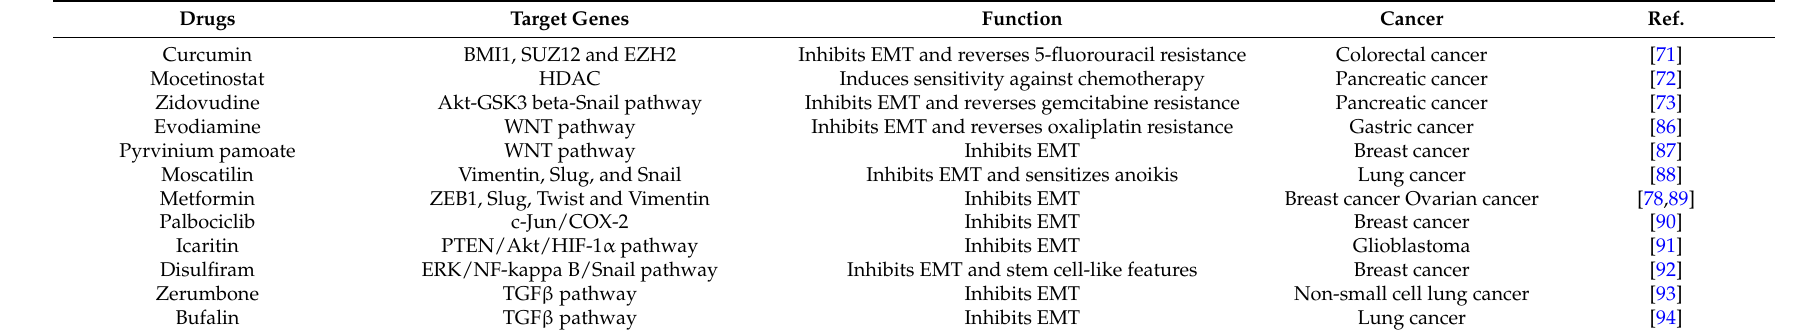
Table 1. Small molecule inhibitors of epithelial–mesenchymal transition (EMT) and their